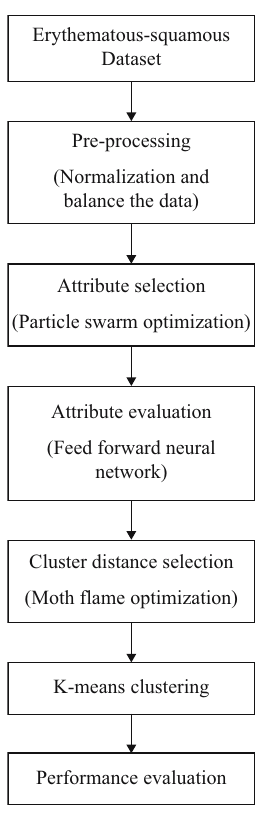
Figure 1: Proposed method process fl